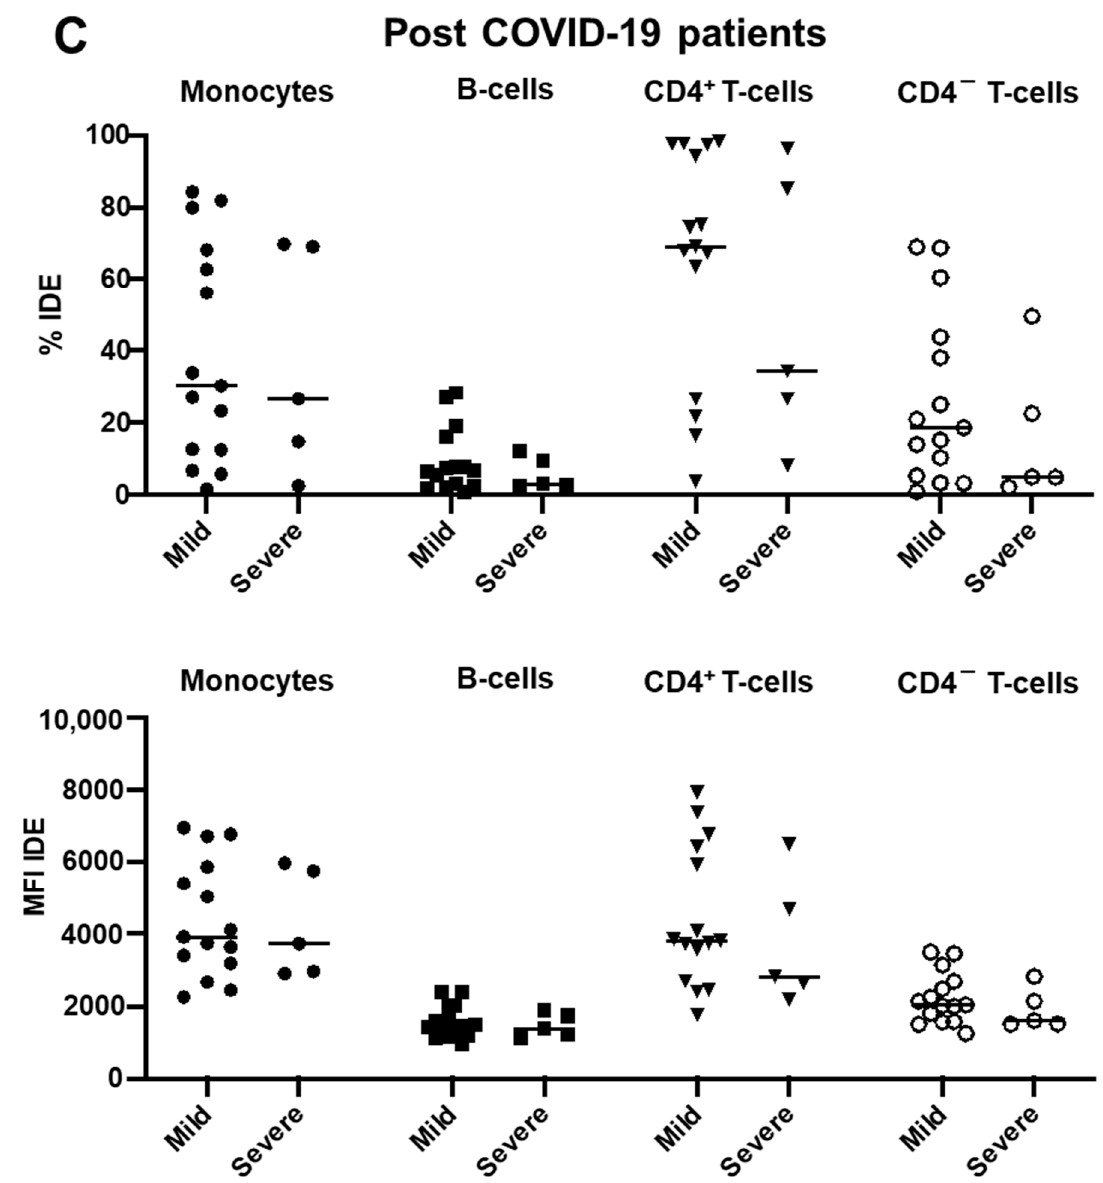
Figure 3. Post-COVID-19 patients have decreased surface expression of IDE on different peripheral blood mononuclear cell subsets. ( A ) The percentages and the median fluorescence indexes (MFI) of IDE expression on monocytes, B-cells, CD4 + T-cells, and CD4 − T-cells were determined as seen in Figure 2. IDE expression was determined in healthy subjects (controls), patients with COVID-19 at diagnosis (COVID-19), and patients with COVID-19 3 months after hospital discharge (post-COVID-19). The data were also analyzed based on the severity—mild or severe—in COVID-19 ( B ) and post-COVID-19 ( C ) patients. One-way ANOVA with a Sidak correction was applied in Figure 3A, while two-way ANOVA with a Sidak correction was applied in Figure 3B,C. * p < 0.05; ** p < 0.01; *** p < 0.001; **** p < 0.0001).